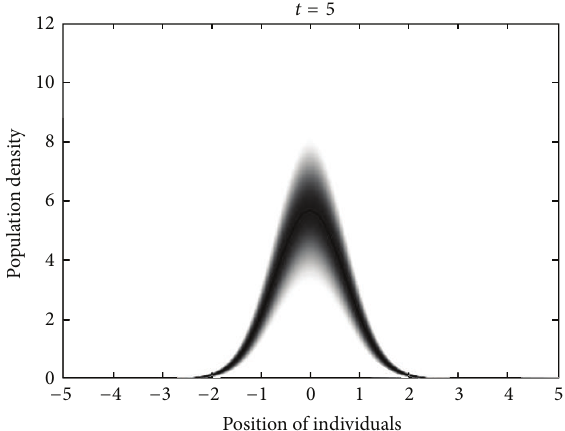
Figure 6: Dimensional graph of the fuzzy solution for 𝑡 = 5 involving only